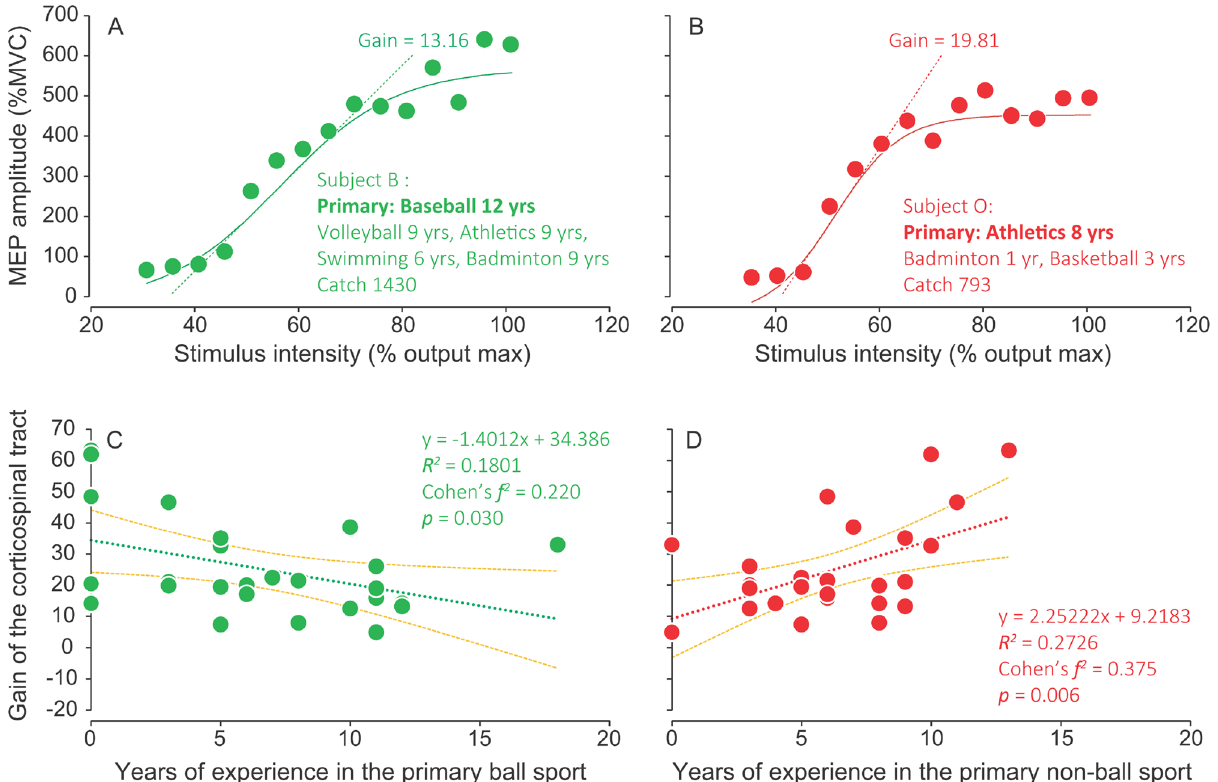
Figure 4. Characteristic relationship between years of sports experience and corticospinal excitability. ( A , B ) A typical input–output curve in participants with longer years of experience in primary ball and non-ball sports, respectively. ( C , D ) Relationship between years of experience in the primary sport (ball and non-ball) and gain of the corticospinal